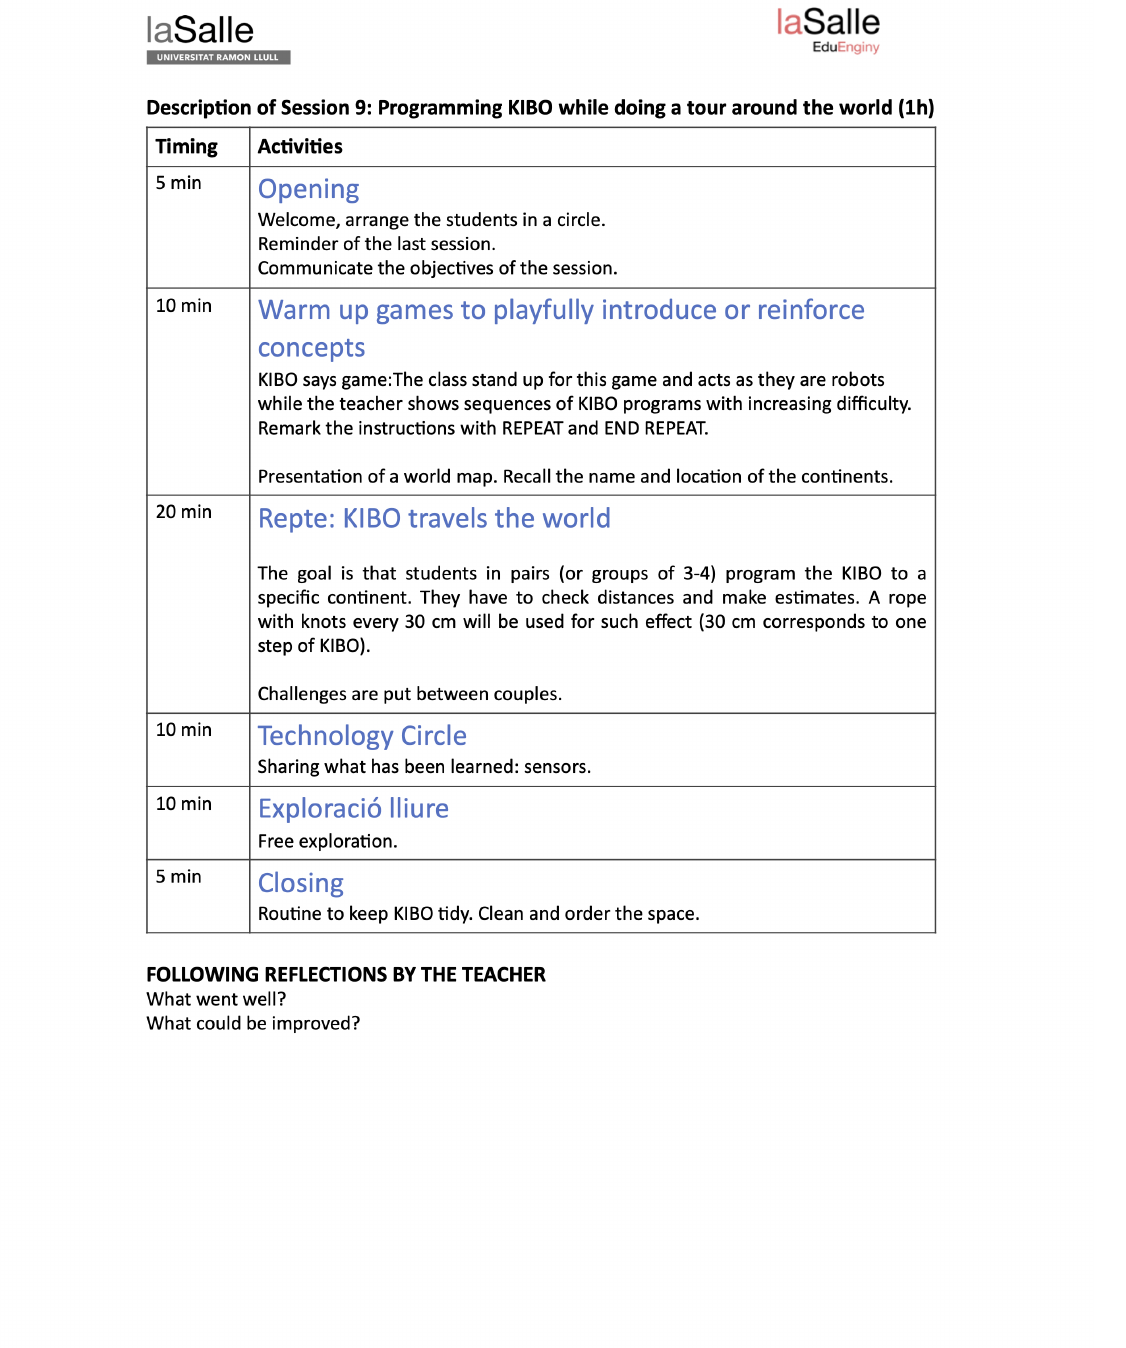
Figure A1. Details of a sample session of the developed